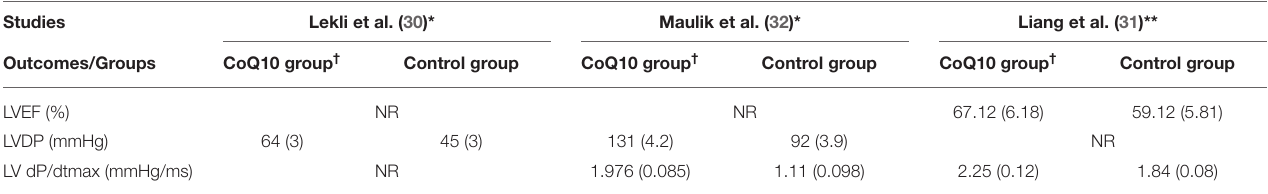
TABLE 4 | Summary of results on cardiac function